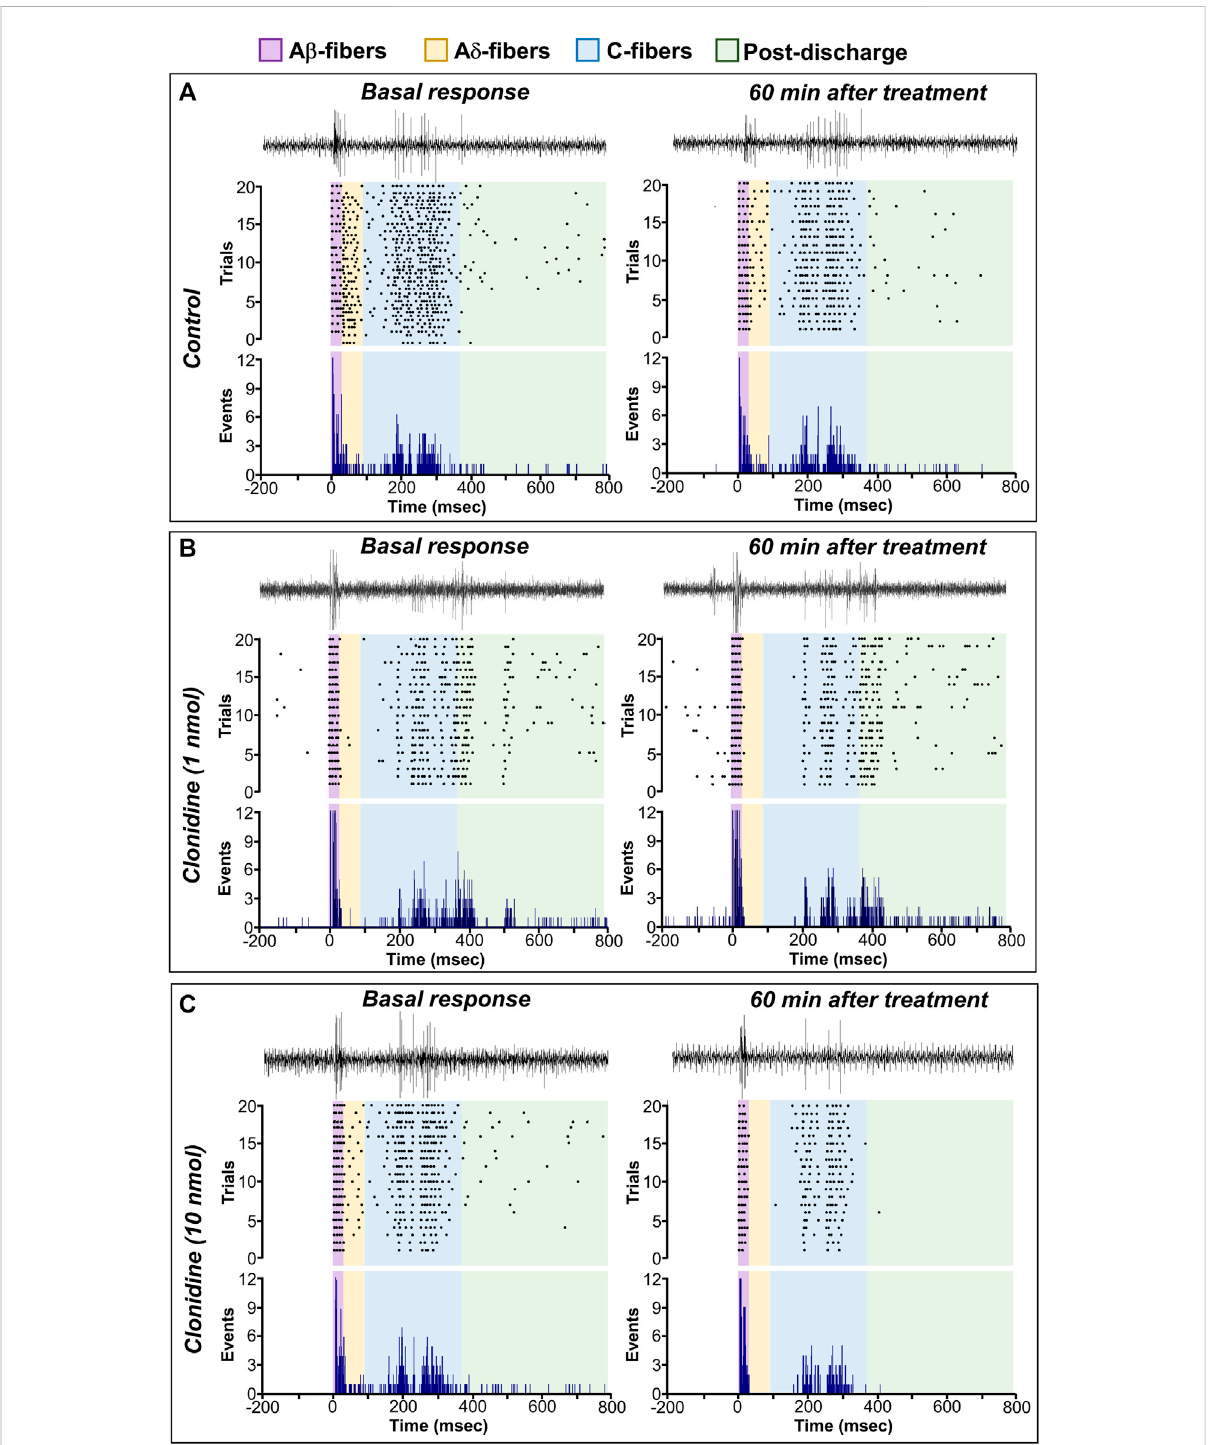
FIGURE 5 Spinal clonidine selectively blocks the nociceptive neuronal fi ring of WDR cells. (A – C) depict the raw tracing of a single second-order WDR neuron cluster response induced by one electrical stimulus (upper tracing), the raster plot (middle), and peri-stimulus time histograms (PSTH) constructed from 20 WDR responses to receptive fi eld (RF) electrical stimulation before (basal) and after treatment. In accordance with the fi ber conduction velocities, the panels in the fi gure depict the different fi ber components (A β -, A δ -, C- fi bers, and post-discharge) of the spinal WDR cell response. Note that clonidine (1 and 10 nmol) diminished the neuronal activity; this clonidine-induced inhibition (observed as a diminution of events) is mainly associated with neural action on nociceptive fi bers (i.e., A δ - and C- fi bers) and ongoing (post-discharge) activity, whereas the fi ring of A β - fi bers remains